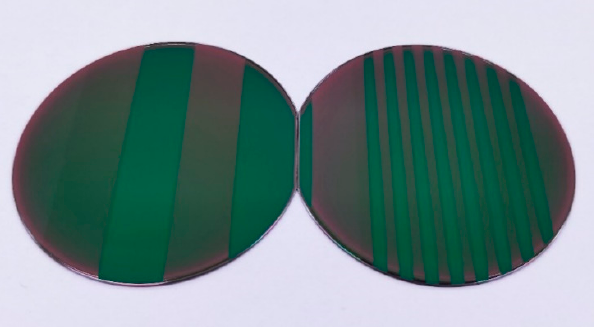
Figure 10. The sample of dual channel bandpass thin film filter with different widths of channels. The green color area is the 3.55–3.75 µm filter, the blue color area is the 4.85–4.95 µm filter, the substrate is 2 inch double-polished silicon wafer.